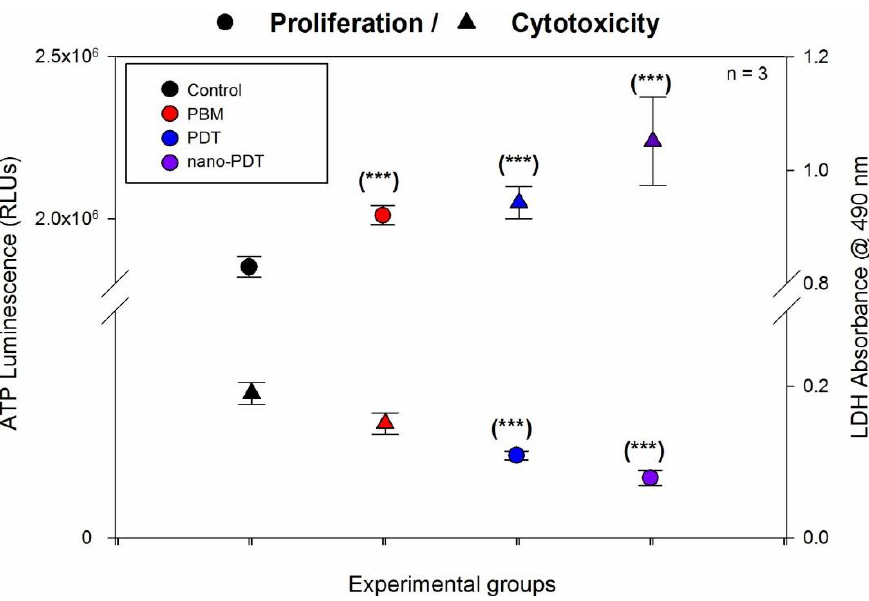
Figure 5. Proliferation and cytotoxicity of lung epithelial carcinoma cells (A549) 24 h post-PDT treat- Figure ment.